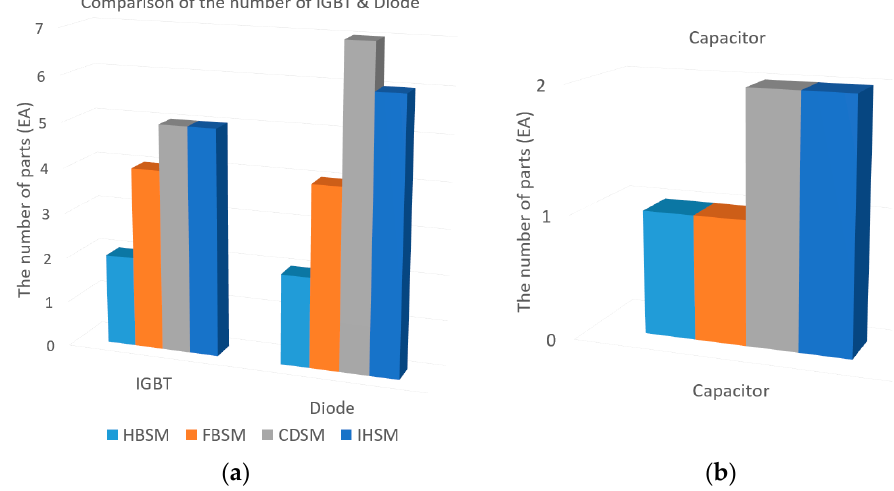
Figure 21. Comparison of the number of components, ( a ) IGBT, diode, ( b ) capacitor.